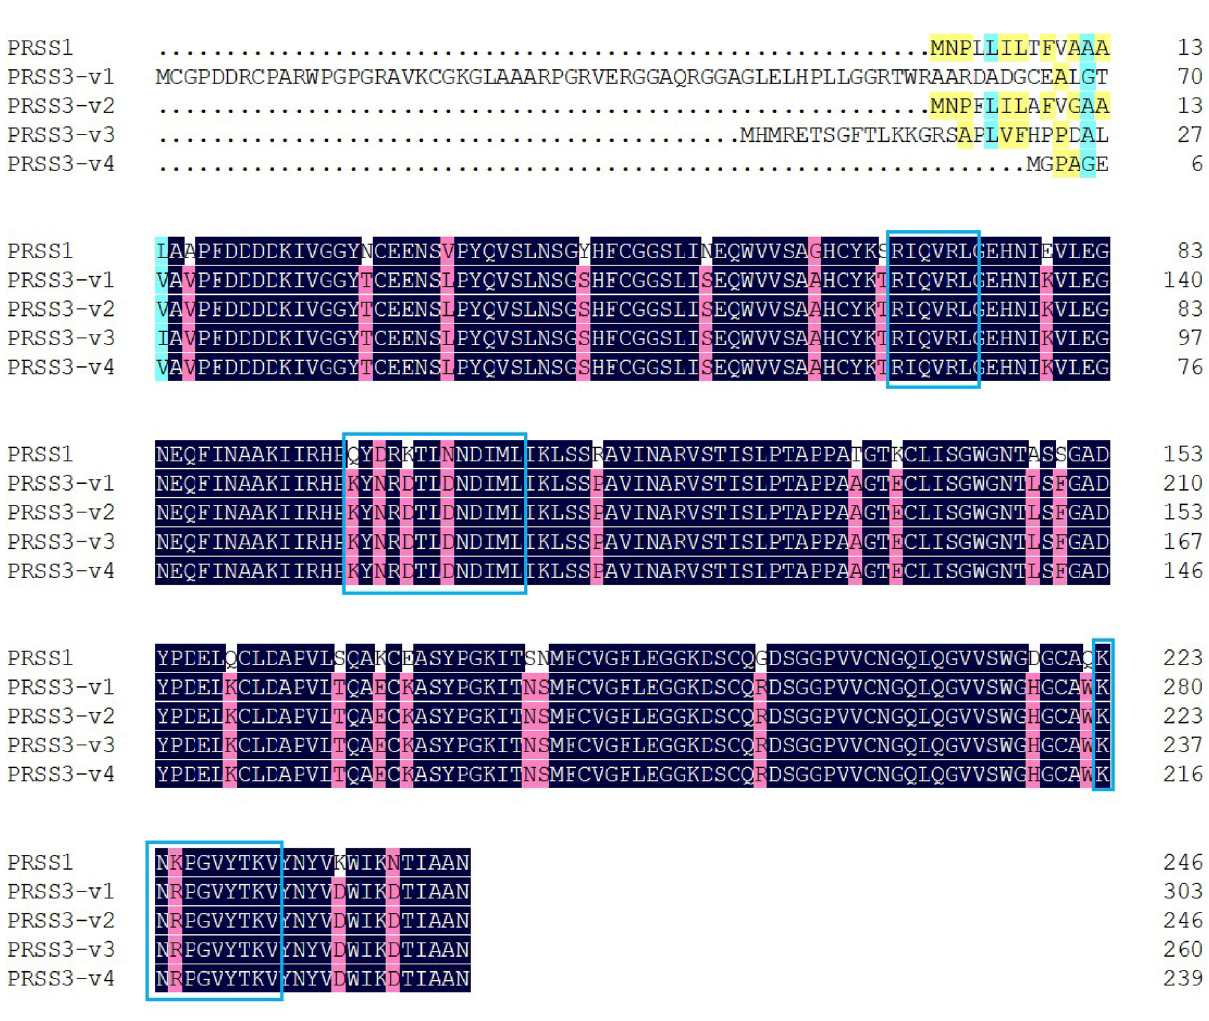
Figure 2. Multialignment of amino acid sequences of PRSS1 and four PRSS3 transcript variants (PRSS3 variants 1–4; PRSS3-v1 to PRSS3-v4 ) by DNAMAN program. Highlight homology level: blue = 100%, pink ≥ 75%, cyan ≥ 50%, and yellow ≥ 33%. The peptide sequences generated by LC-MS/MS including RIQVRL, KTLNNDIMLIKL, and KNKPGVYTKV, identified as PRSS1 or PRSS3 were highly similar to amino acid sequences shown in the blue